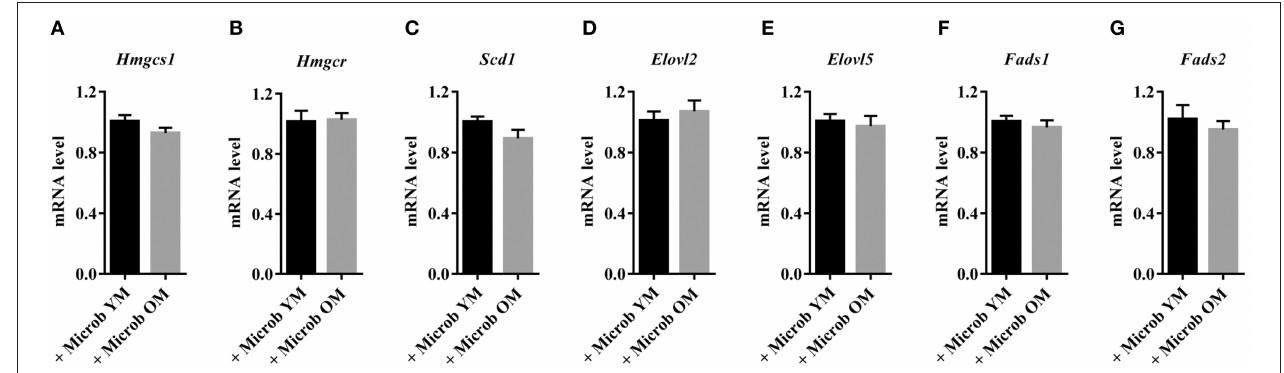
FIGURE 4 | Cortical expression of enzymes involved in cholesterol synthesis in mice harboring age-dependent microbiota. (A,B) Cortical expression of genes encoding enzymes involved in the biosynthesis of cholesterol: (A) hydroxymethylglutaryl-CoA synthase ( Hmgcs1 ) and (B) 3-hydroxy-3-methylglutaryl-CoA reductase ( Hmgcr ). (C–G) Cortical expression of genes encoding enzymes involved in the biosynthesis of fatty acids: (C) acyl-CoA desaturase 1 ( Scd1 ), (D,E) elongation of very long chain fatty acids proteins 2 and 5 ( Elovl2 and Elovl5 ), (F) acyl-CoA (8-3)-desaturase ( Fads1 ) and (G) acyl-CoA 6-desaturase ( Fads2 ). The levels of mRNA were normalized to Hprt mRNA level for calculation of the relative levels of transcripts. mRNA levels are illustrated as fold change. All data are presented as mean ± SEM. n = 7 for the group of mice inoculated with the microbiota of young mice and n = 8 for the group of mice inoculated with the microbiota of old